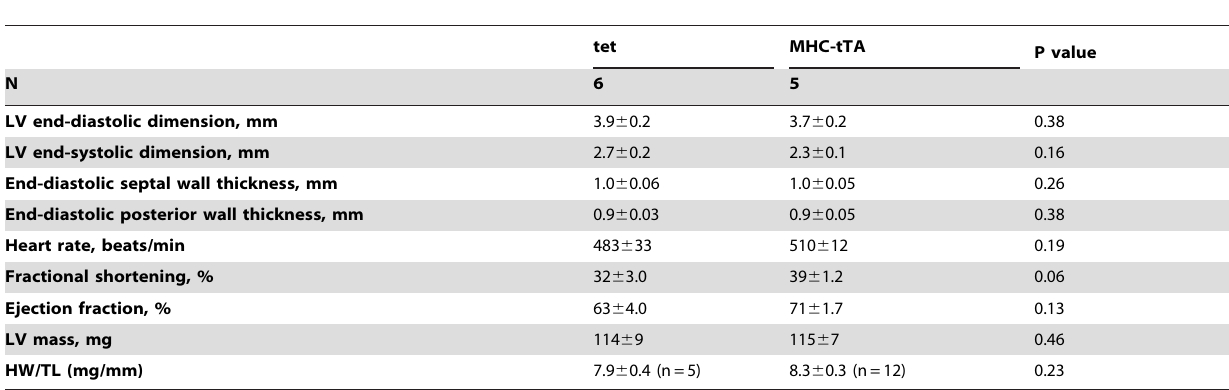
Table 1. Echocardiographic Measurements and Heart weight/tibia